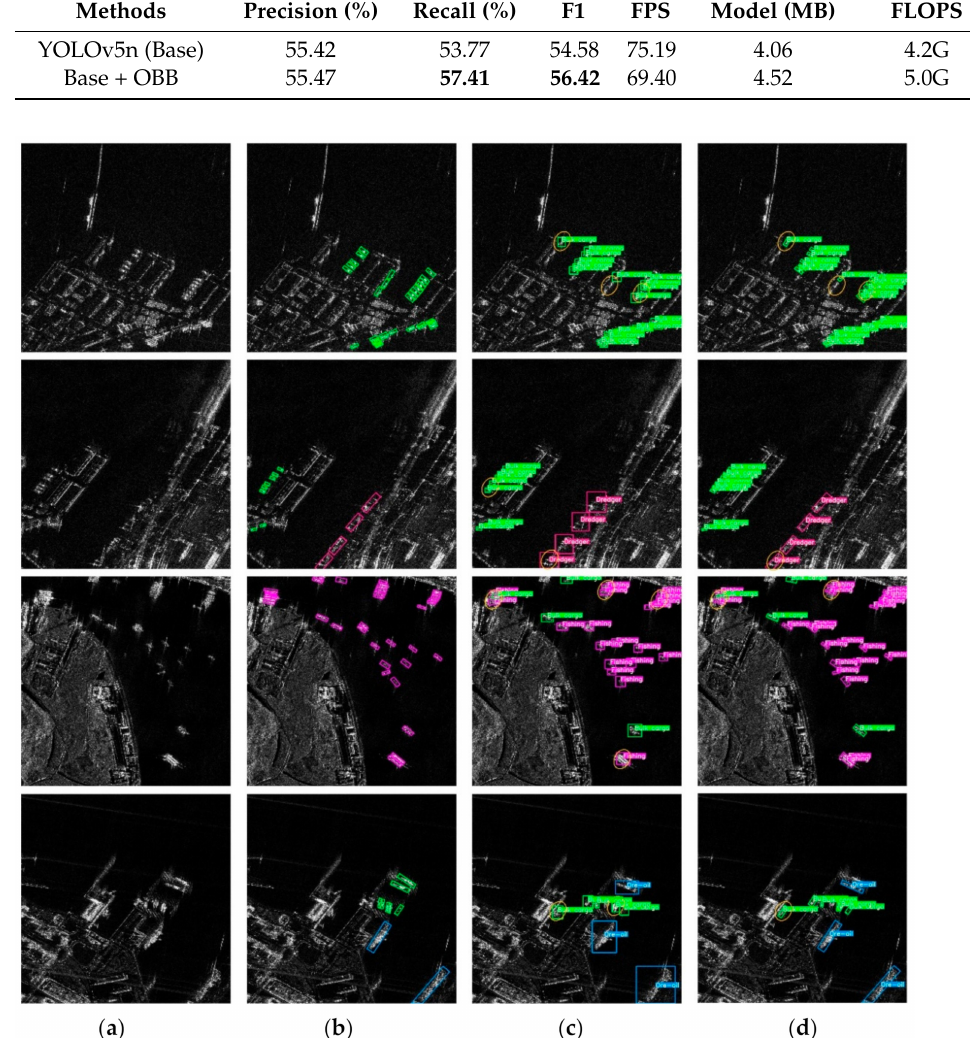
Figure 9. Detection results of different prediction methods on SRSDD. ( a ) The original SAR images. ( b ) The ground truth. ( c ) HBB prediction results. ( d ) OBB prediction results. Yellow ellipse indicates a false